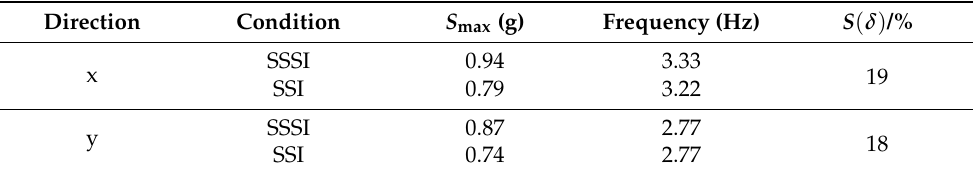
Table 9. Comparison of FRS at different locations of raft foundation (2–10 Hz) of SSI system and SSSI system.